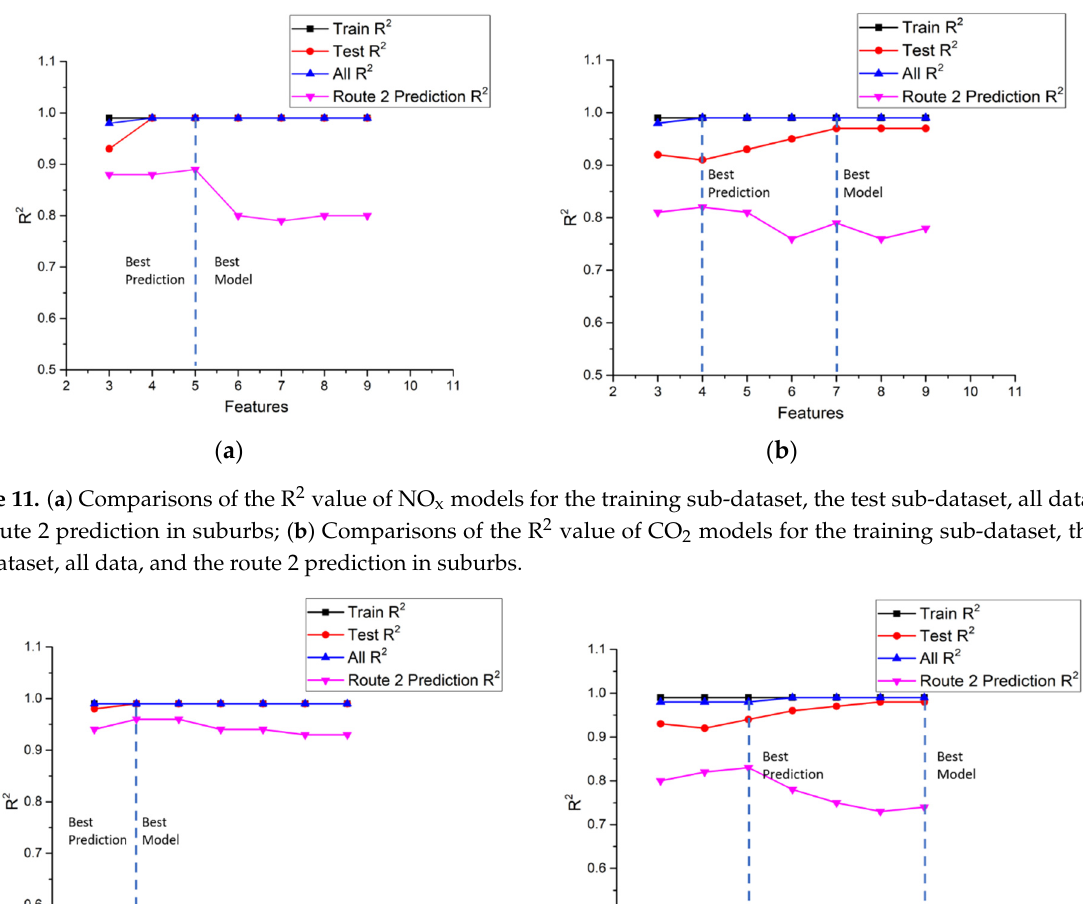
Figure 10. ( a ) Comparisons of the R 2 value of NO x models for the training sub-dataset, the test sub-dataset, all data, and the route 2 prediction in urban; ( b ) Comparisons of the R 2 value of CO 2 models for the training sub-dataset, the test sub-dataset, all data, and the route 2 prediction in urban.